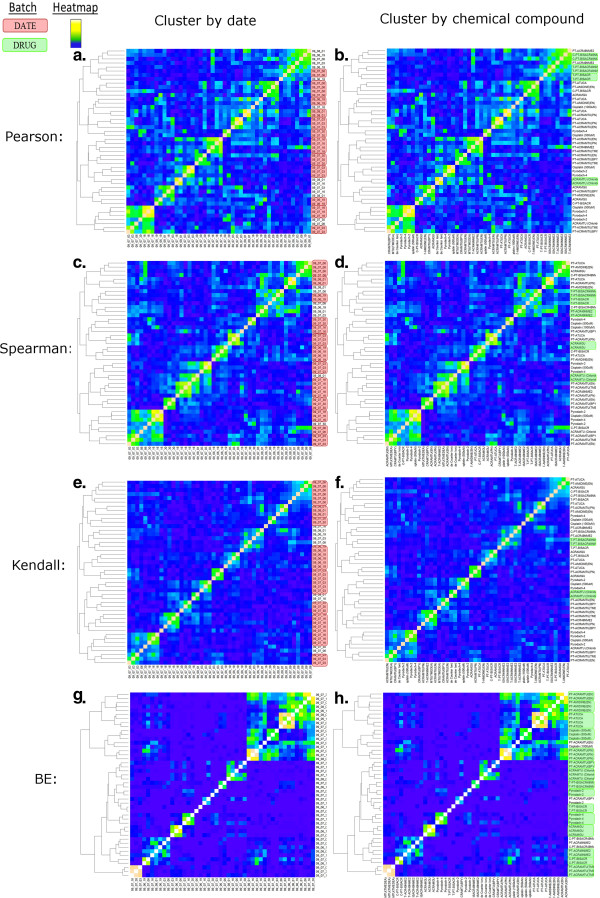
Shabtai et al. Comparison of several correlation method outcomes using TAG4 Microarray dataset. Four correlation methods applied to the same dataset were clustered to show the performance of BE compared to other methods. The left column displays the cluster of experiments where the labels are the dates on which the experiment was performed (a, c, e, g). Adjacent identical dates are displayed in a red rectangle to indicate when clustering occurs by date. The right column displays the cluster of experiments where the labels are the chemical compound that was used for each experiment (b, d, f, h). Adjacent identical chemical compounds are displayed in a green rectangle to indicate when the same chemical compounds are clustering together. The desired result of a cluster is that similar conditions will cluster together. Examining the Pearson correlation cluster, the experiments cluster by date (a), due to a date batch effect. The BE method minimized the batch effect where identical dates did not cluster together (g), while identical conditions (chemical compounds) did cluster together (h).